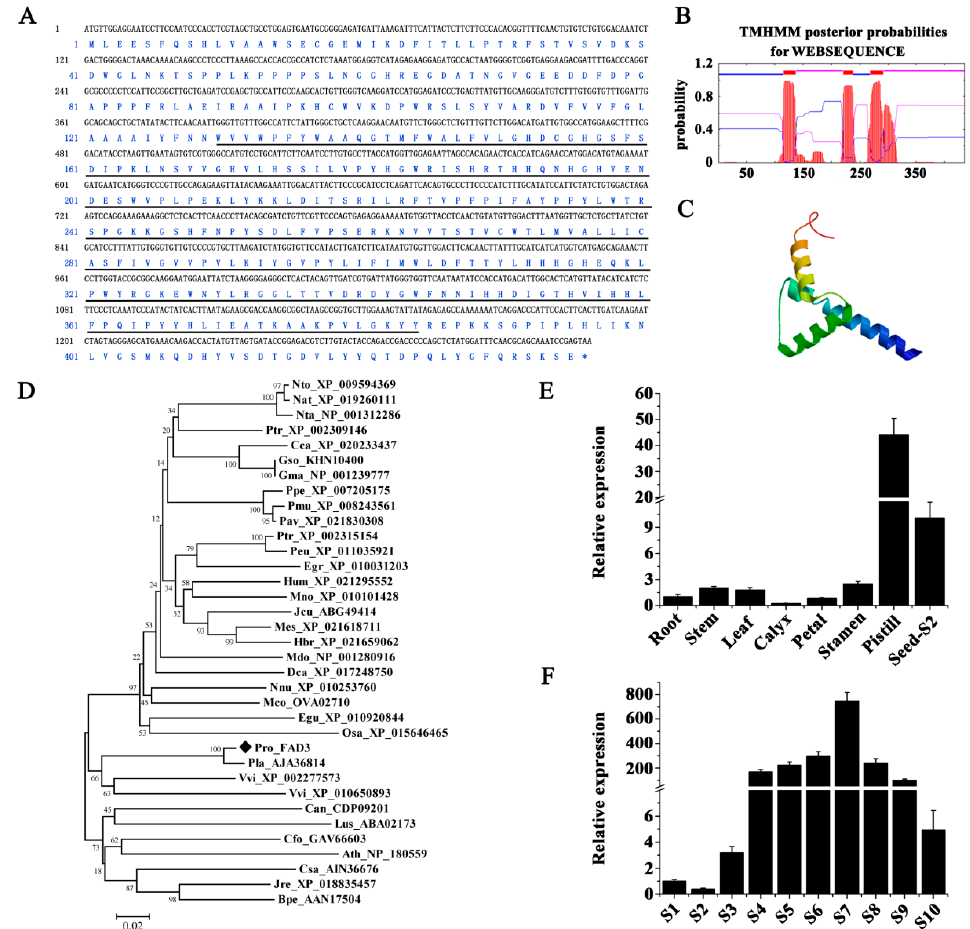
Figure 8. Identification, characterization, and expression analysis of PrFAD3 in P. rockii . ( A ) Nucleotide and deduced amino acid sequence of PrFAD3 . Solid lines indicate the conserved 1-acyl- sn -glycerol-3-phosphate acyltransferase-related domain. Prediction of the ( B ) transmembrane domains and ( C ) tertiary structure of Pr FAD3 protein. ( D ) Phylogenetic comparison of the FAD3 proteins in plants (refer to Table S6 for complete names of the plant species). ( E ) Tissue-specific expression of PrFAD3 . ( F ) PrFAD3 expression during P. rockii seed development. S1 to S10 indicate